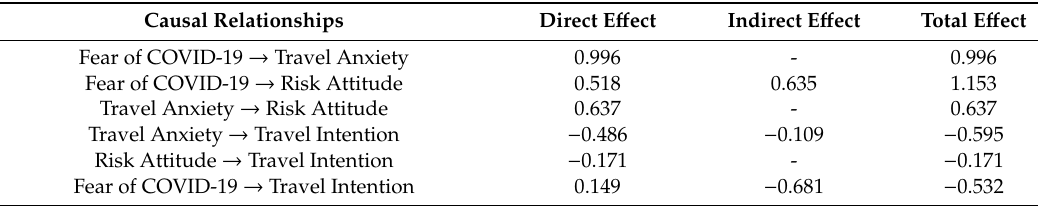
Table 5. Results for Mediation